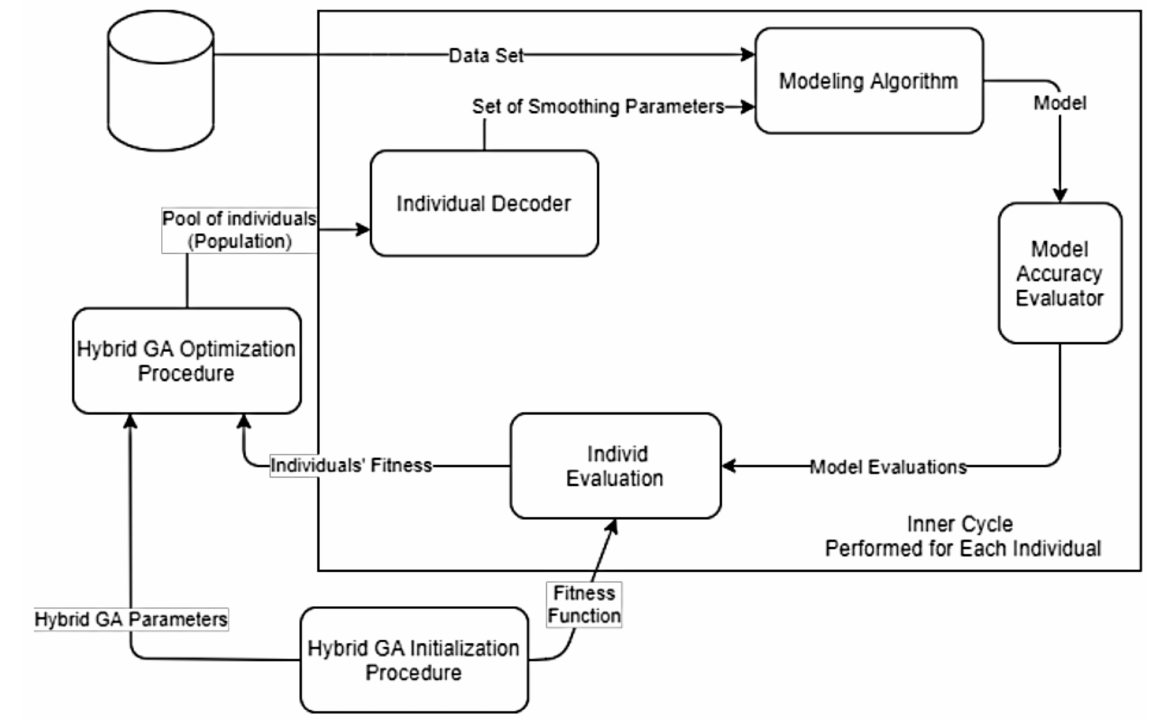
Figure 1. Smoothing-factor optimization scheme.